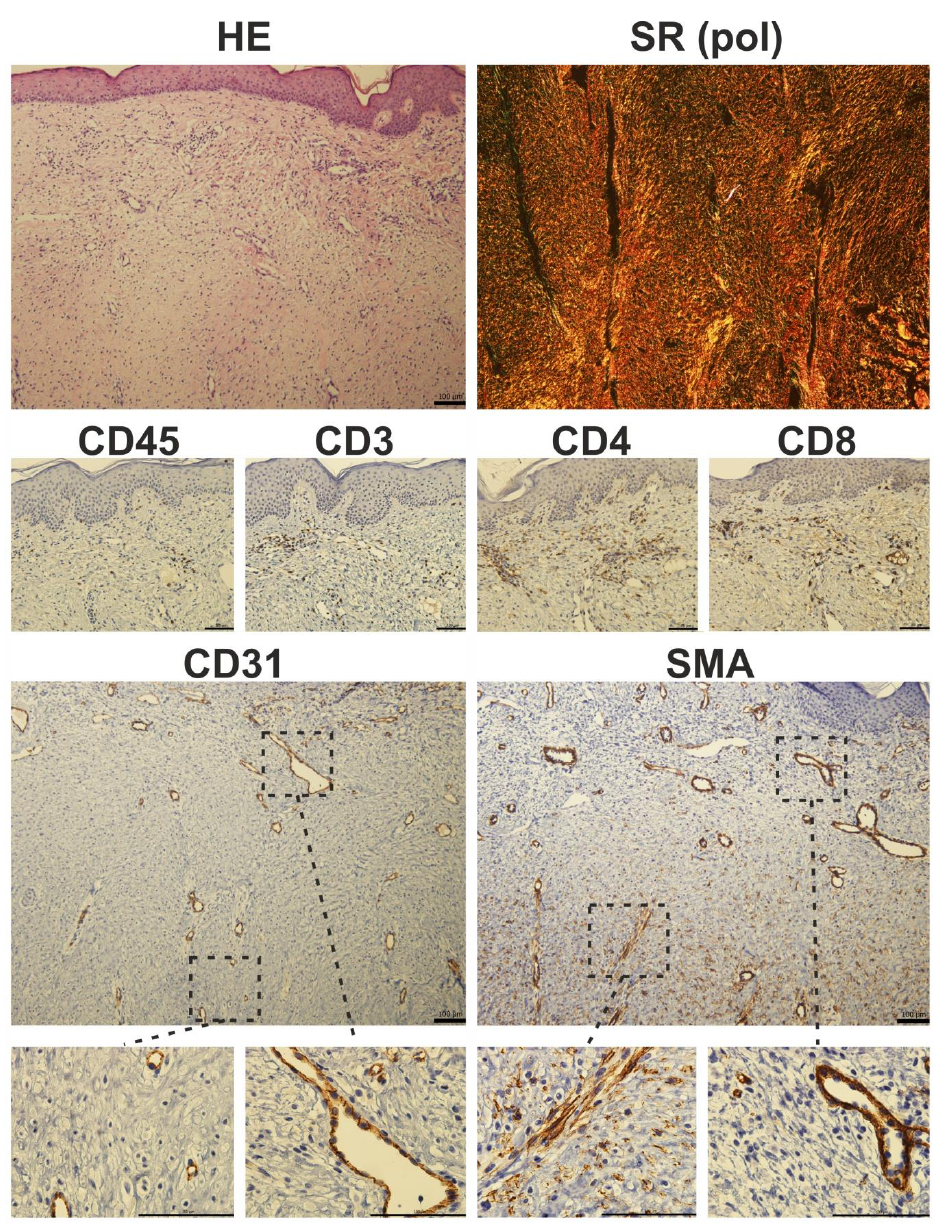
Figure 6. Histological photomicrograph of a hypertrophic scar stained with hematoxylin-eosin (HE) and Sirius red (SR) observed under polarized light (pol). Immunohistochemical staining of a hypertrophic scar. Prolonged inflammation results in the presence of CD45-positive cells in fibrotic tissue. CD3 staining showed characteristic T-cell islands, which were more pronounced after selective staining of CD4 and CD8-expressing T-cell subpopulations. The presence of myo- fibroblasts is restricted to deeper parts of the scar: in detail, α-smooth muscle actin (SMA) positivity was seen in lumi- nized vessels (also positive for endothelial marker CD31), whereas CD31-negative and SMA-expressing cells (myofibro- blasts) were located rather in the deeper parts of the scars (scale 100 µm).